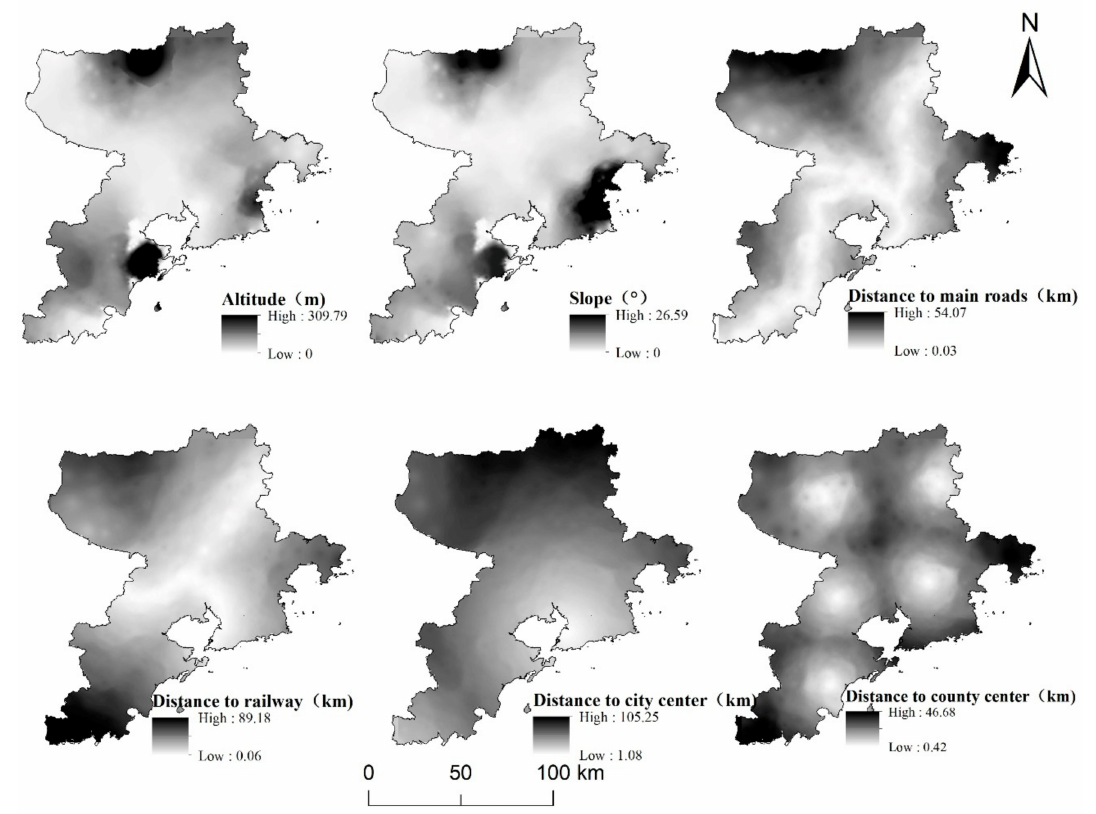
Figure 4. Spatial distribution of three-dimensional location